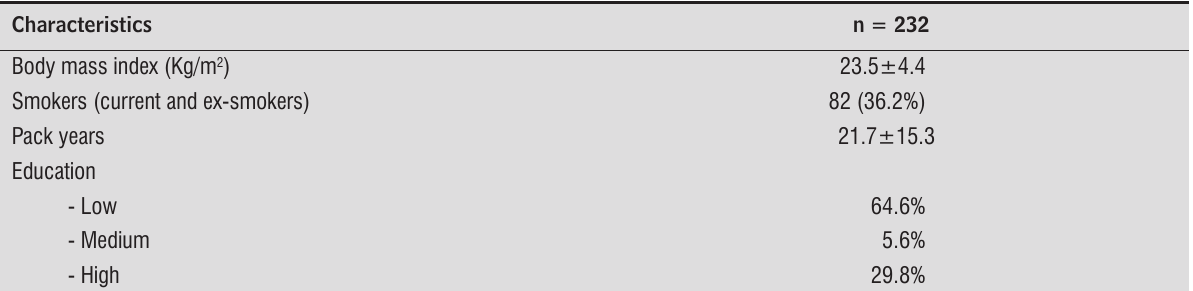
Table 1– Demographic and anthropometric characteristics of sample Characteristics